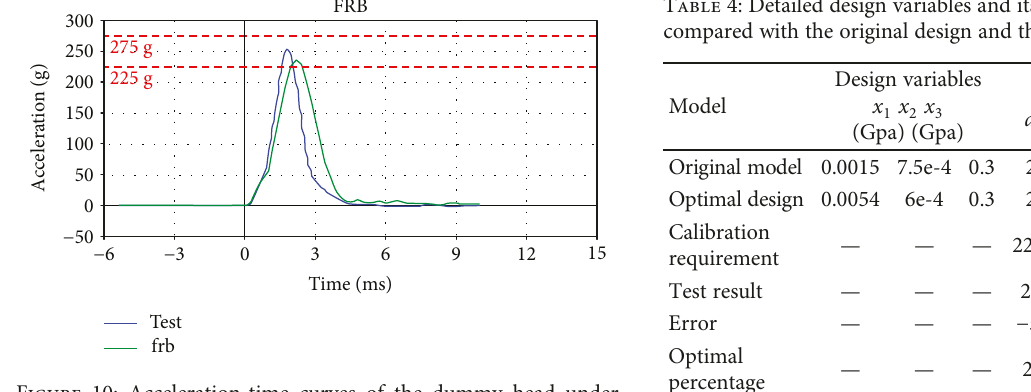
Figure 10: Acceleration-time curves of the dummy head under frontal